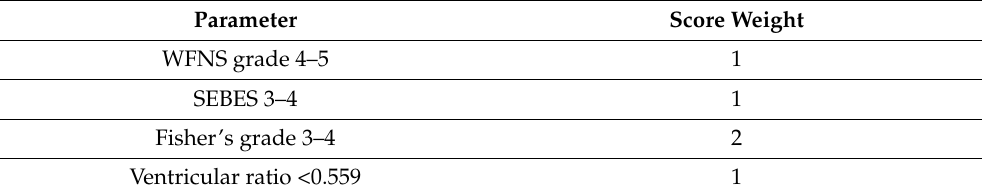
Table 3. Components and weights of parameters in the prediction model for decompressive craniectomy.